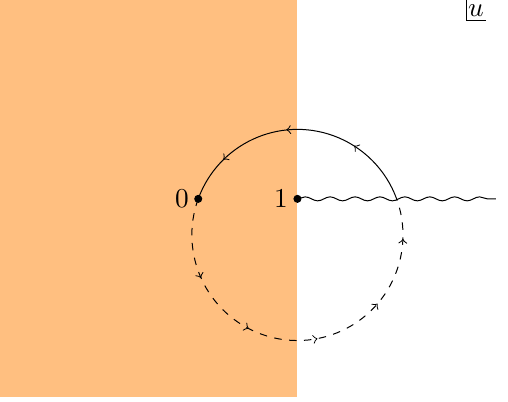
Figure 9 . The path in cross ratio space corresponding to the following con(cid:12)guration in the cor- relator (3.26): (cid:22) z 1 ; 2 = (cid:0)1 , (cid:22) z 12 (cid:12)nite, z 2 ( (cid:0)1 ; + 1 ) with the i (cid:15) prescription of eq. (3.27). In this case, (cid:24) = 0, and the path is a circle with radius 1 + ( z 1 (cid:0) z 2 ) 2 = 4 (cid:15) 2 . The region < u < 1, shaded in orange, is the region of convergence of the O L (cid:2) O L OPE. As usual, the i (cid:15) shift prescribes how to avoid the singular points, located at u = 1 and u = 1 . In general, u = 1 and u = 1 are branch points, so that the path starts on the second sheet | the dashed part | and ends in the Euclidean region | the solid part. Compare with the path in spacetime, (cid:12)gure 8. The picture is